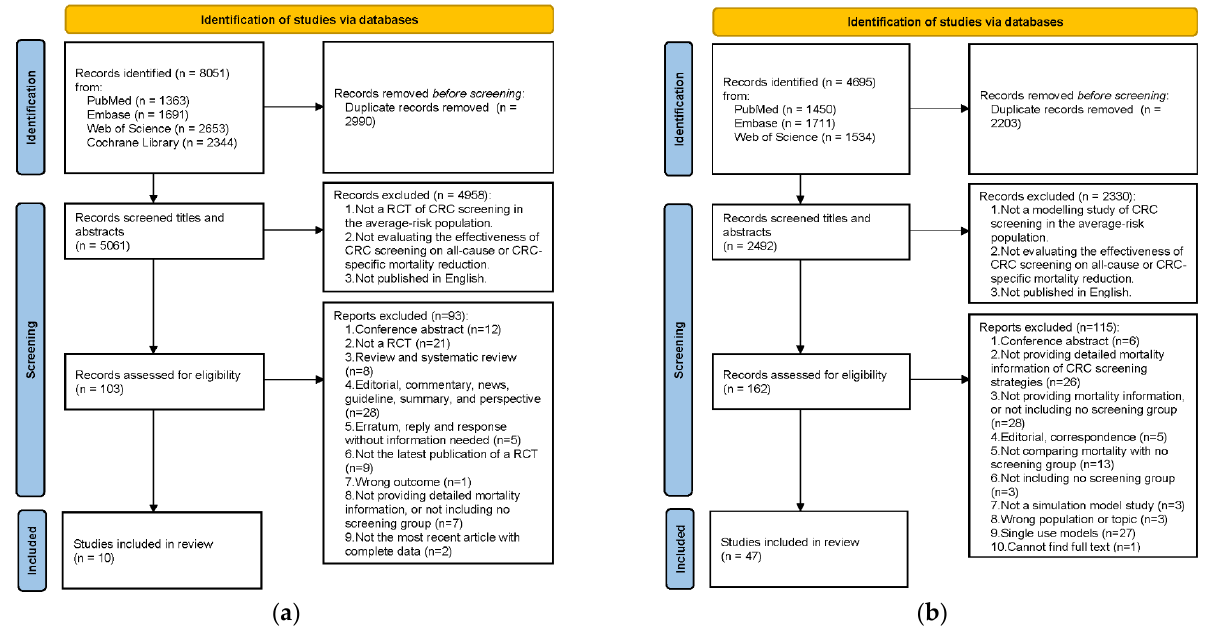
Figure 1. Flowchart of the selection process. ( a ) Studies on RCTs; ( b ) Studies on simulation model studies.